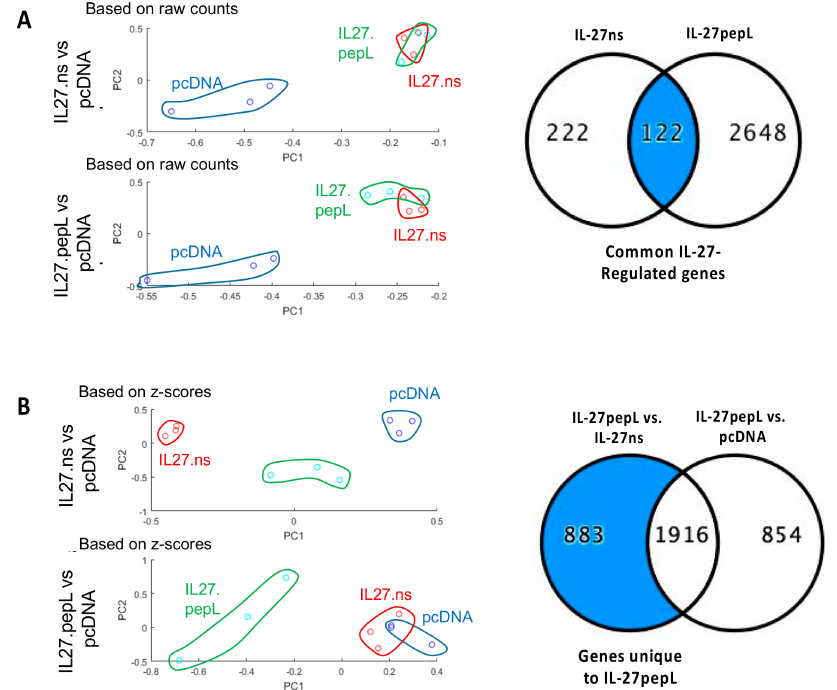
Figure2. Di ff erentglobalgeneexpressionanalysesfollowingRNA-sequencing(RNAseq)data